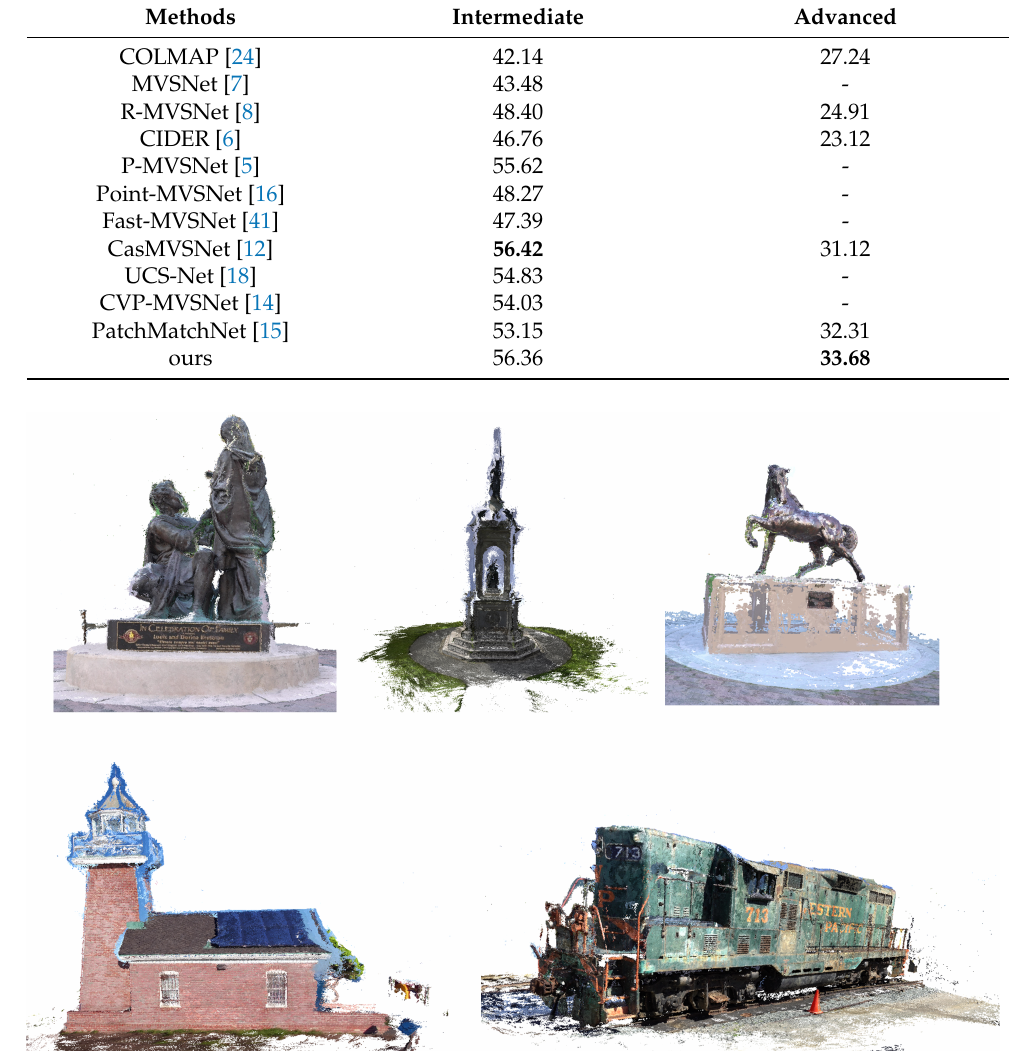
Table 2. Quantitative results of different methods on Tanks and Temples [10] (F score, higher is better). Note that most methods avoid evaluation on more challenging advanced datasets.